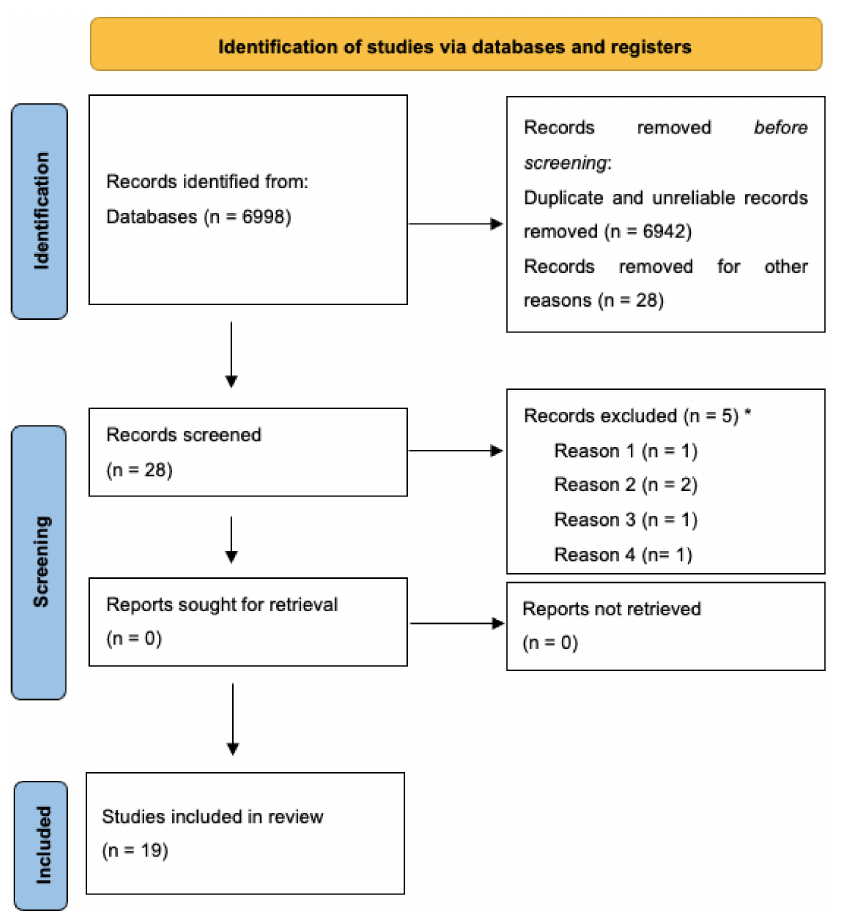
Figure 1. PRISMA 2020 flow diagram for the review process. * Reason 1: BFB on other physiological signals (e.g., electromyography, temperature, skin conductance); reason 2: HRV assessment without BFB; reason 3: unclear primary or secondary outcomes; reason 4: sample of patients without cancer diagnosis. Reprinted with permission from Page et al. (2021). Copyright 2020 The PRISMA